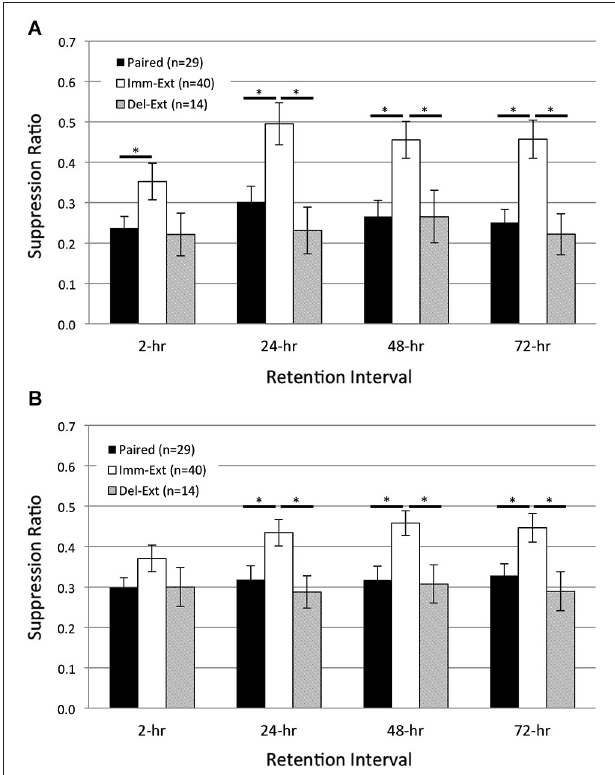
FIGURE 5 | Delayed behavioral extinction did not attenuate pairing-produced phototactic suppression. Summary data for start (A) and finish (B) latency suppression ratio (SR) scores measured at four different RIs post-acquisition. Animals given delayed extinction training 23 h after the conclusion of paired conditioning ( Del-Ext group) showed significant phototactic suppression (i.e., smaller SR scores) compared to animals given immediate extinction training ( Imm-Ext group) 15 min after paired conditioning, for both the start and finish latency measure at the 24-, 48-, and 72-h RIs. Del-Ext animals were no different than Paired animals (not exposed to extinction) at any RI, for either the start or finish latency measure. Imm-Ext animals displayed significantly less phototactic suppression than Paired animals for start latency behavior at the 2-h RI, and less suppression for both start and finish latency behavior at the 24-, 48-, and 72-h RIs. Error bars are ± S.E.M and significant p values ( p ’s < 0.05) are denoted by an